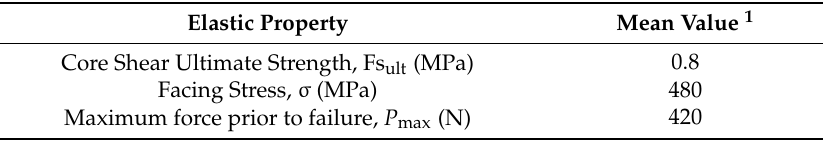
Table 7. Mechanical properties of AS4 Spreadtow-EPOLAM 2019-PVC sandwich.